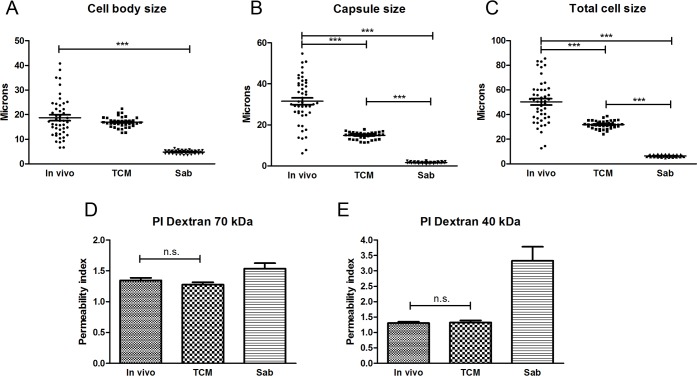
Comparison of titan cells obtained in vivo with enlarged cells obtained in vitro.Measurements of cell body (A), capsule (B) and total cell sizes (C) of cells isolated from infected mice (in vivo) and cultured in TCM and Saboraud in vitro. D and E show the permeability index of 70 and 40 kDa fluorescent labelled dextrans respectively in the same type of samples (see M&M).